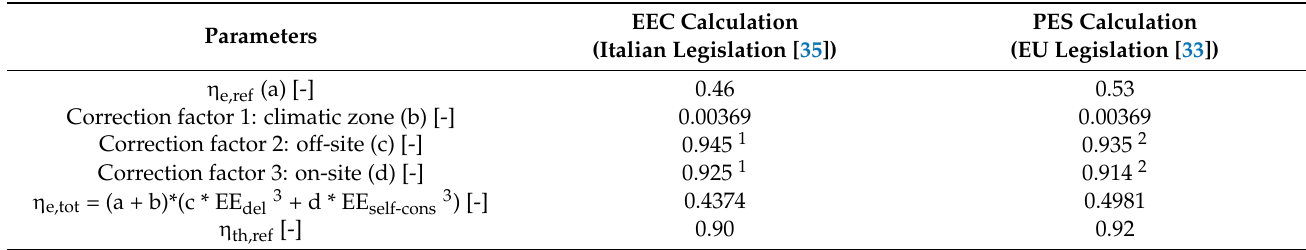
Table 3. Different correction factors values and electric and thermal reference efficiencies.